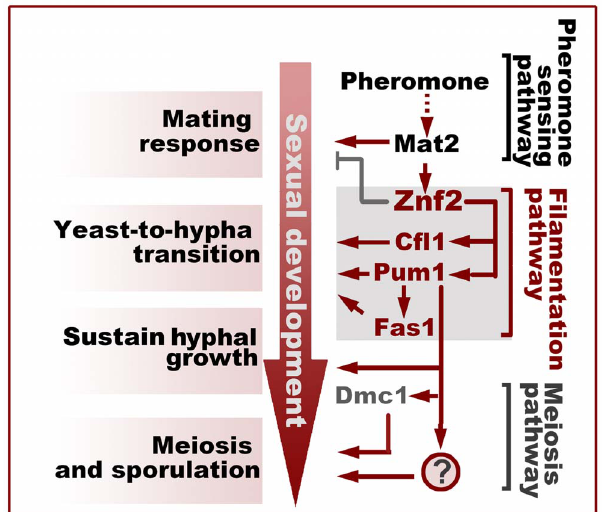
Figure 8. Filamentation pathway coordinates sexual reproduc- tion and morphogenesis in Cryptococcusneoformans . Activation of Znf2 promotes the filamentous growth and modestly inhibits the early mating behaviors that initiate the transition from the yeast form to the hypha form [7,12]. Cfl1 and Pum1 represent two parallel major branches downstream of Znf2 in the orchestration of this morpholog- ical switch. Pum1 plays additional important roles in sustaining hyphal growth and in bridging hyphal development and sexual reproduction partially through its control over the expression of DMC1 and FAS1 . The question mark indicates unidentified factors controlled by Pum1 that regulate meiosis and sporulation.